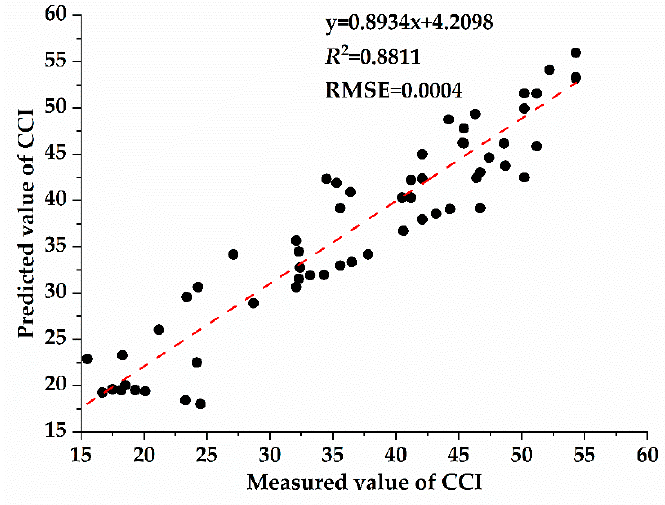
Figure 8. Test of chlorophyll inversion model based on red valley reflectance.